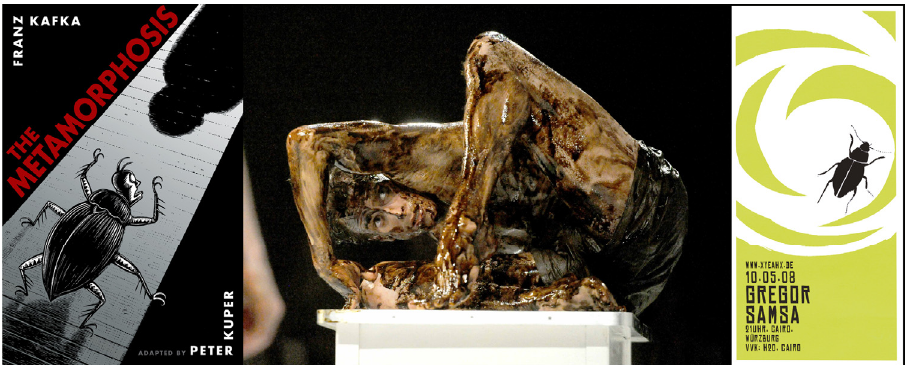
Figure 4. Franz Kafka’s The Metamorphosis has crept into many crevices of popular culture. Peter Kuper adapted Kafka’s novella into a graphic novel (left). Edward Watson played Gregor Samsa in Arthur Pita’s stage production in The Linbury Studio, United Kingdom (center). A music band based in Virginia, USA adopted the name Gregor Samsa (right). Cover, photograph, and graphic design reproduced with permission from Peter Kuper [65], Alastair Muir [66], and Oliver Hummel